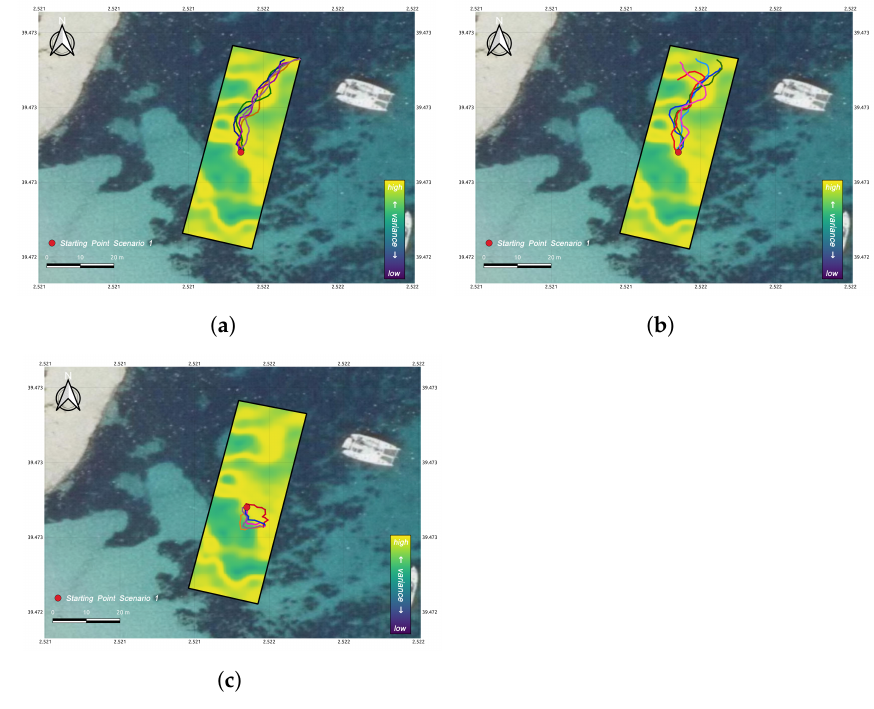
Figure 6. Five best paths Area 2-Scenario 1. ( a ) Genetic; ( b ) Random; ( c )